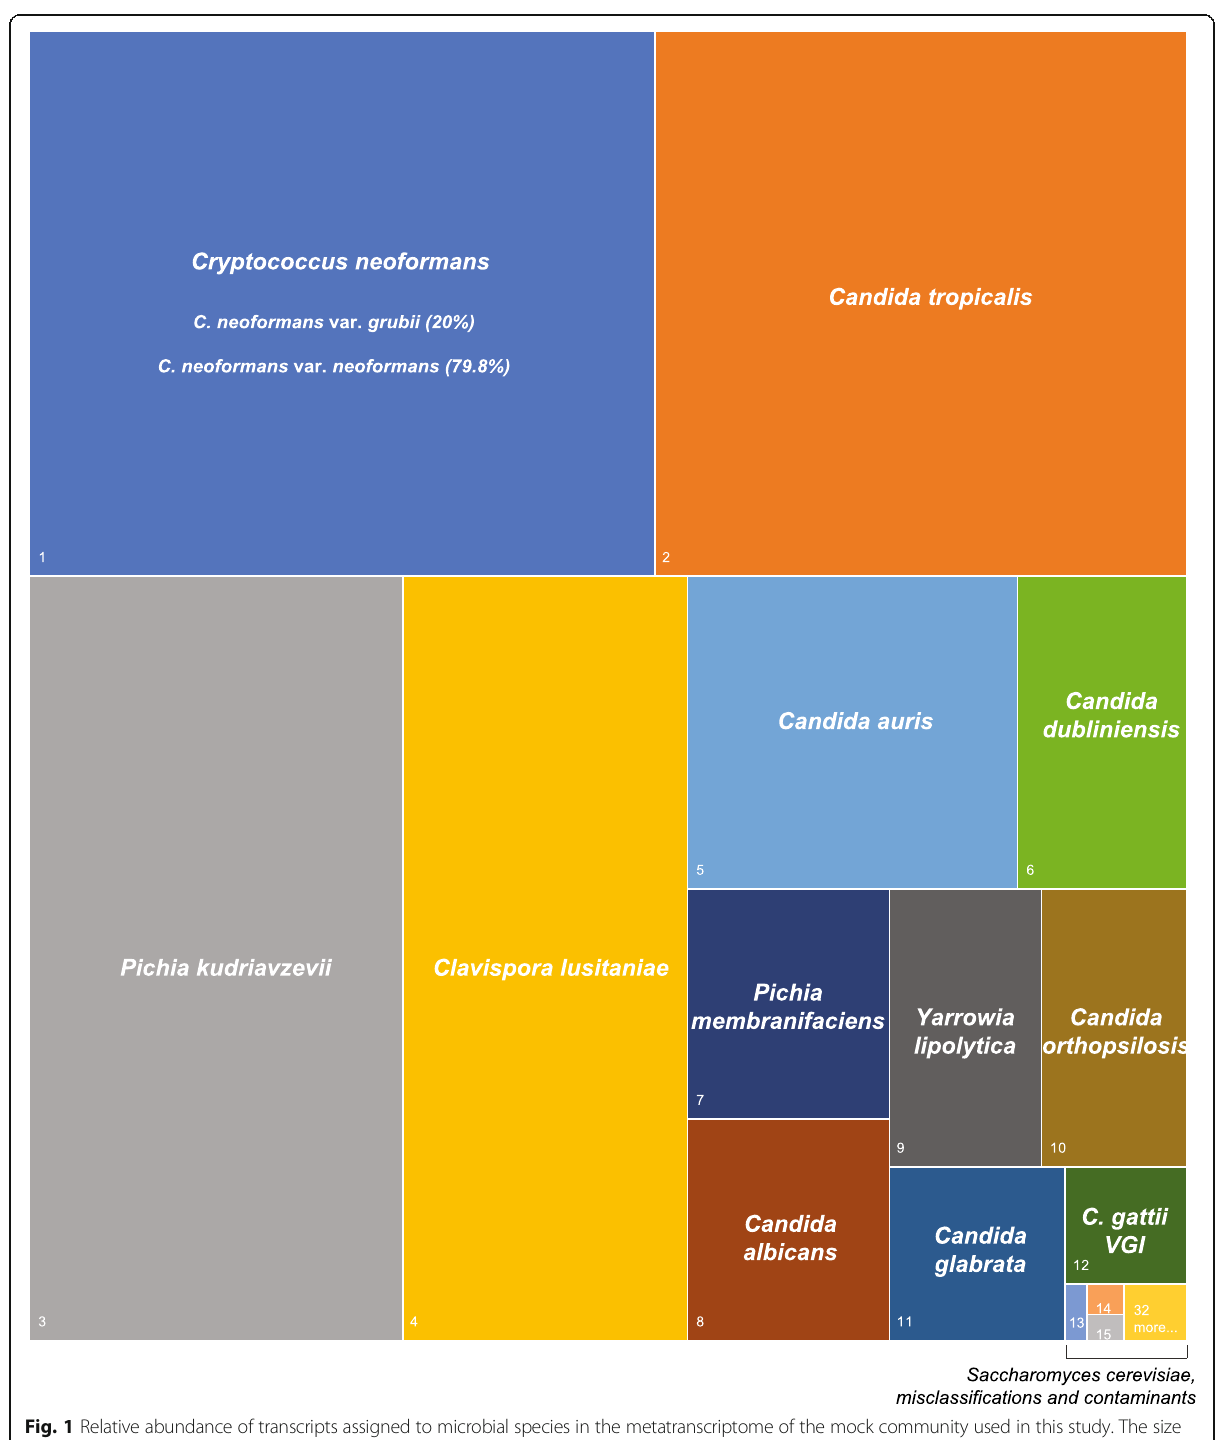
Fig. 1 Relative abundance of transcripts assigned to microbial species in the metatranscriptome of the mock community used in this study. The size of the rectangles represents the relative abundance of different species. See Table 2 for a full list of species and more details about their